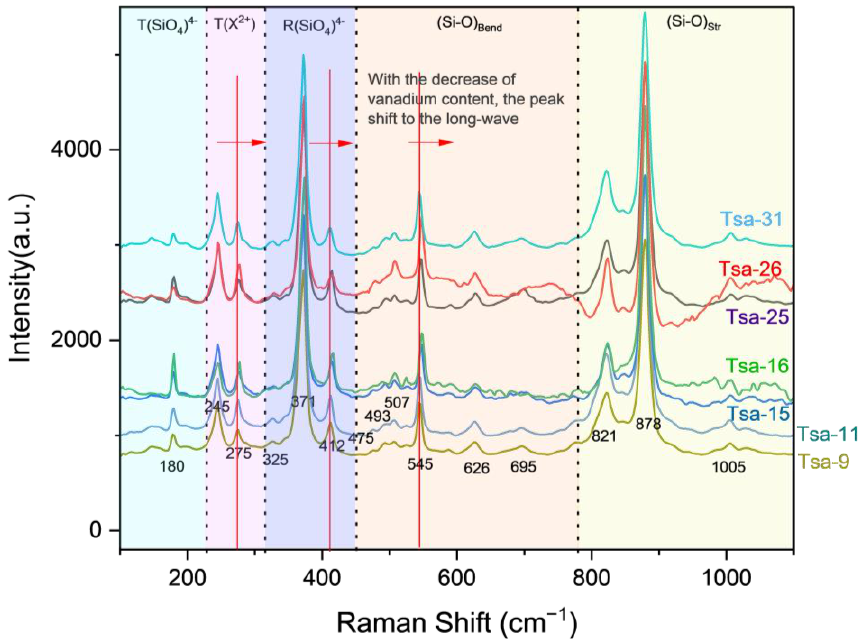
Figure 10. Raman spectroscopy of 7 tsavorites. The order of vanadium content from small to large is: Tsa-16, Tsa-26, Tsa-15, Tsa-25, Tsa-11, Tsa-9,